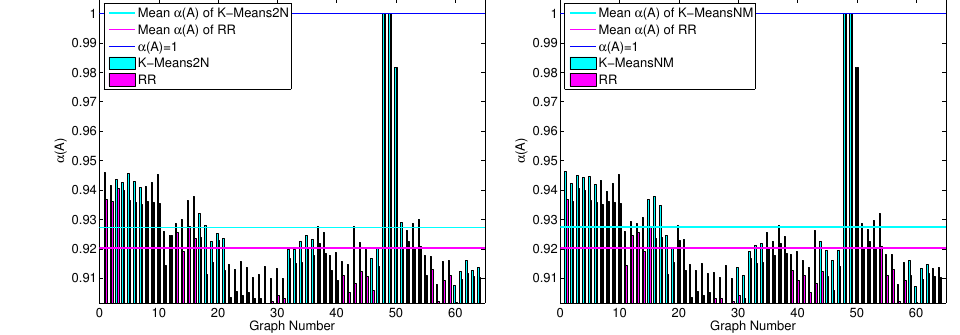
( e ) Comparison of α ( A ) for K-Means2N and RR. ( f ) Comparison of α ( A ) for K-MeansNM and RR. Figure 3. Comparison of instance-specific performance bounds α ( A ) between clustering algorithms and RR. The cyan line is the average of α ( A ) for the clustering methods and the magenta line is the average of RR for